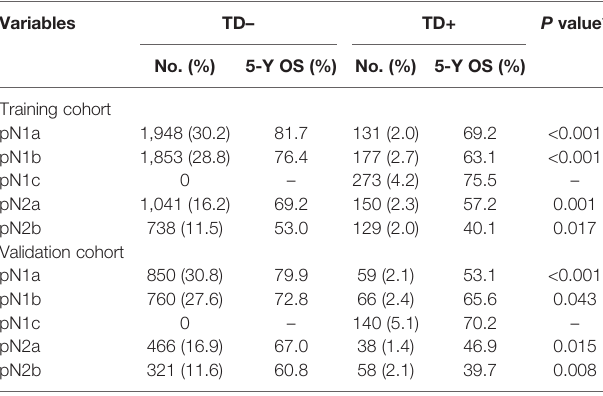
TABLE 3 | Comparison of 5-year overall survival rates in patients with and without TDs in pN stage. Variables